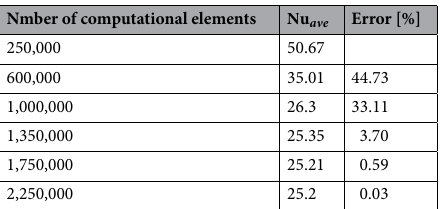
Table 2. Specifications of different models for grid independency.